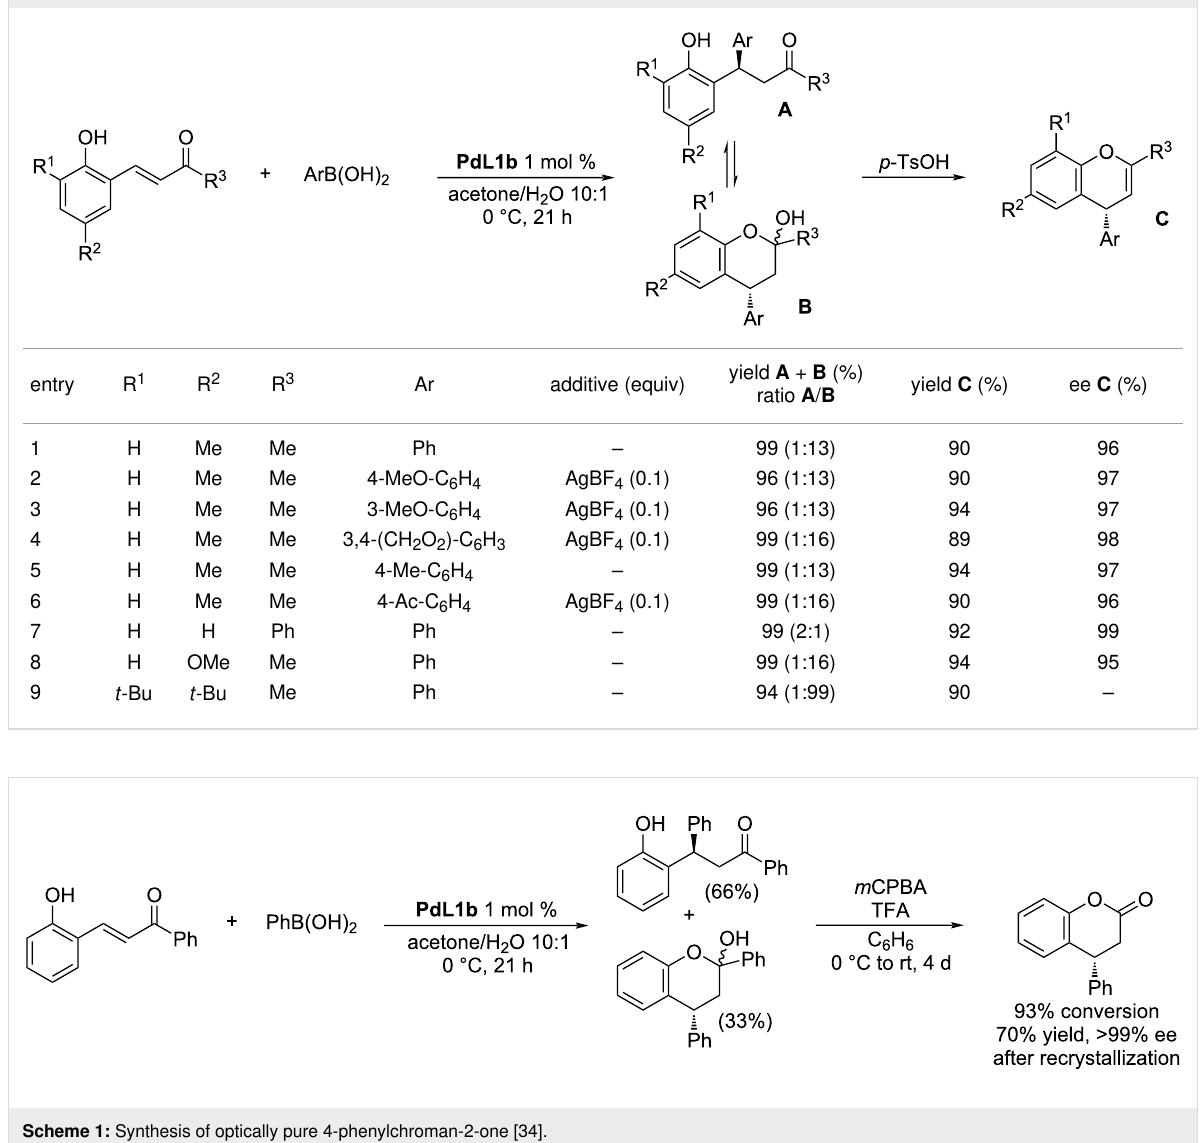
Table 3: Synthesis of chromenes by the 1,4-addition of boronic acids to β -(2-hydroxyaryl)enones